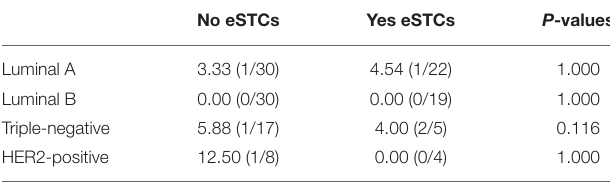
TABLE 2 | Frequency of recurrences in breast cancer patients with eSTCs.